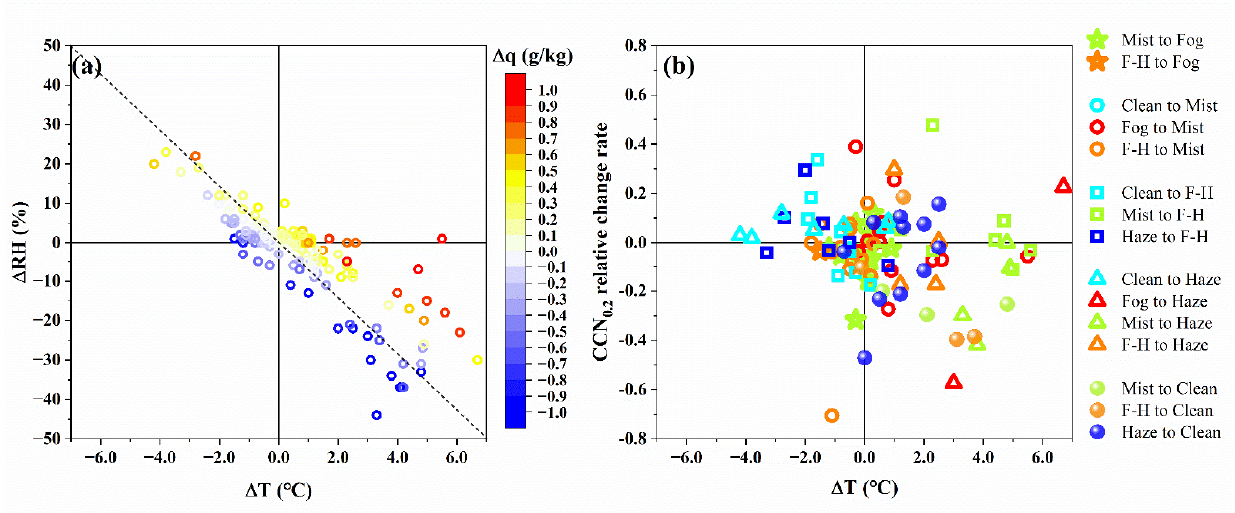
Figure 6. ( a ) Response of relative humidity change ( Δ RH) to temperature change ( Δ T) and specific humidity ( Δ q) change during the evolution of LVEs. ( b ) Scattering of temperature difference ( Δ T) vs. CCN 0.2 relative change rate in the evolution of LVEs. The abbreviation for fog–haze event is F ‐ H.